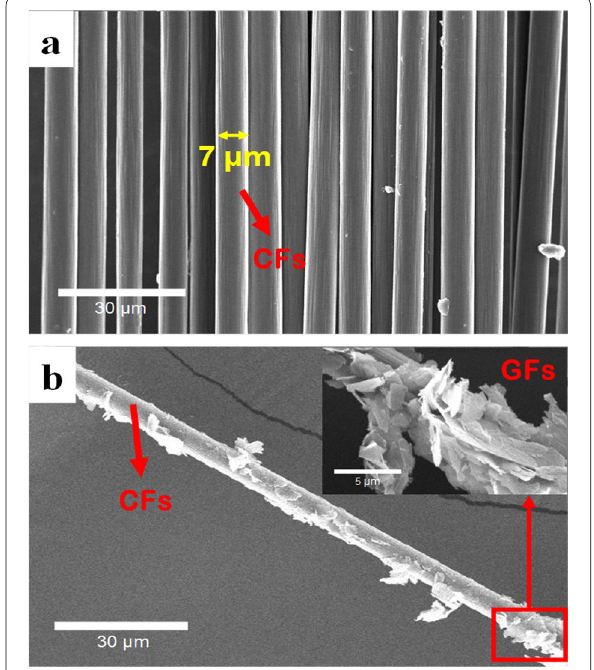
Fig. 4 FE-SEM images: a before and b after being coated with GFs on the surface of CFs